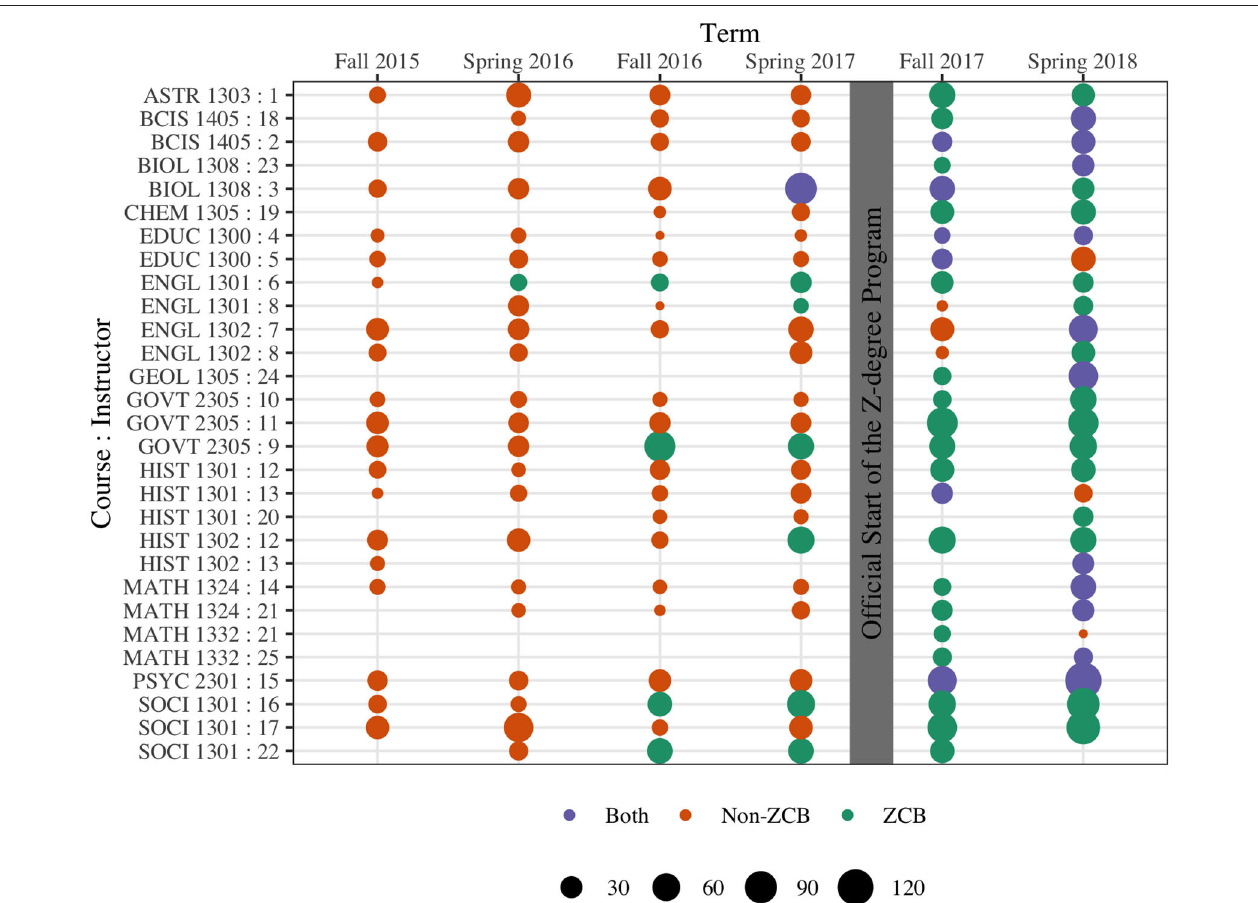
FIGURE 1 | Overview of the ZCB usage by each instructor. Color of the points indicate the type of material used (ZCB or Non-ZCB). Size of the points indicate the number of students.